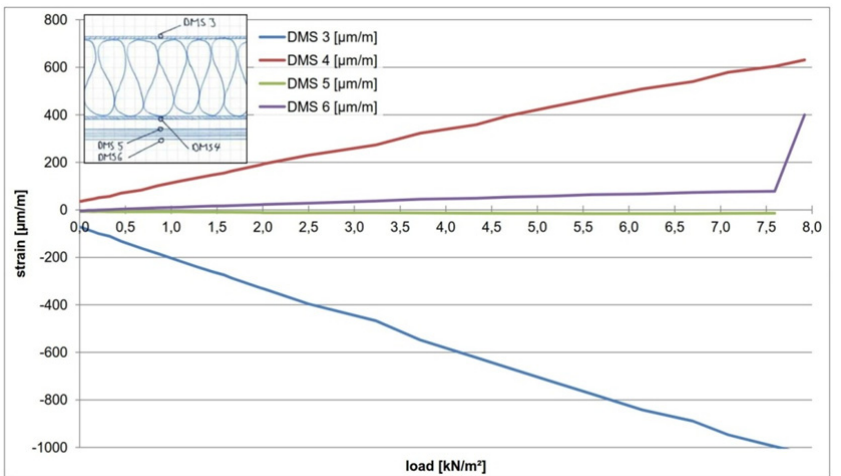
Fig. 10 Position of strain gauges (“DMS #3 to #6”) at metal sheets and glass and exemplary strain distribution in glass sandwich